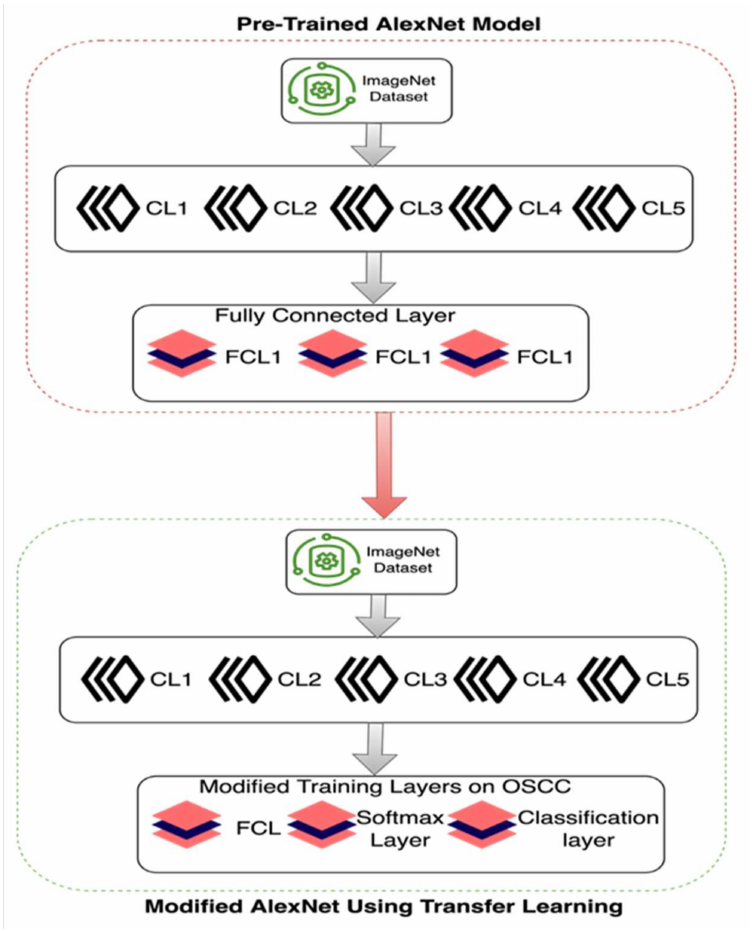
Figure 4. Customized AlexNet for oral cancer prediction using transfer